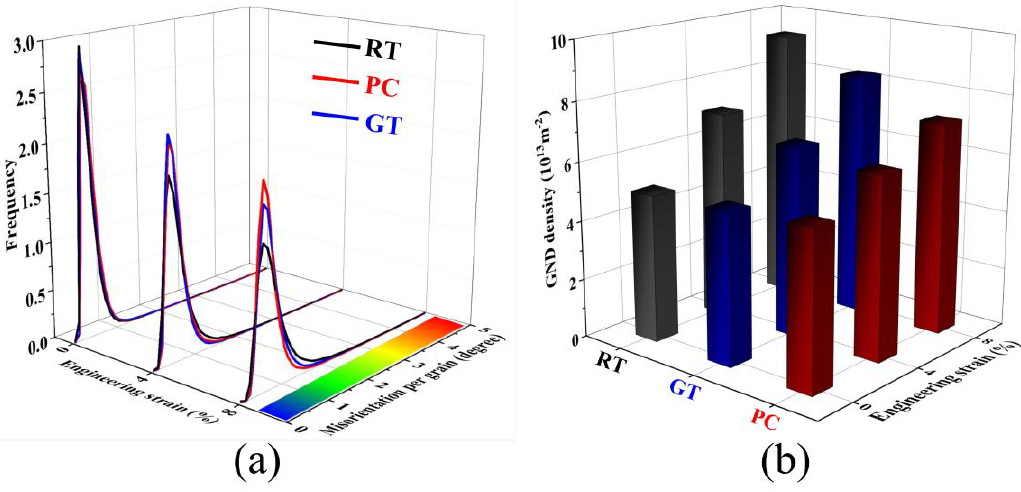
Figure 5. ( a ) The distribution of misorientations per grain and ( b ) geometrically necessary dislocation (GND) density.